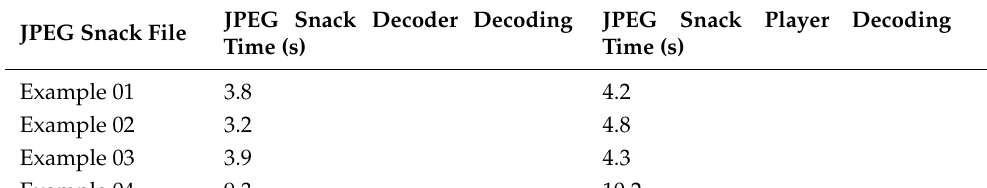
Table 2. Comparison of decoding time of JPEG Snack Player and JPEG Snack decoder.